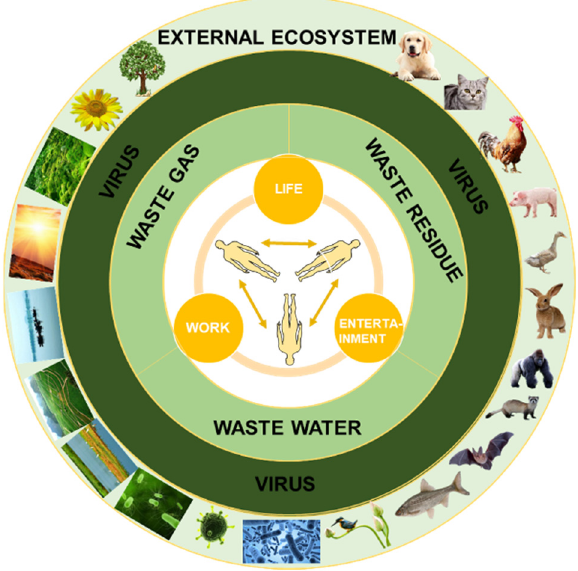
Figure 4. A brief diagram of virus spread from people’s life, work, and entertainment to the external environment via three wastes containing